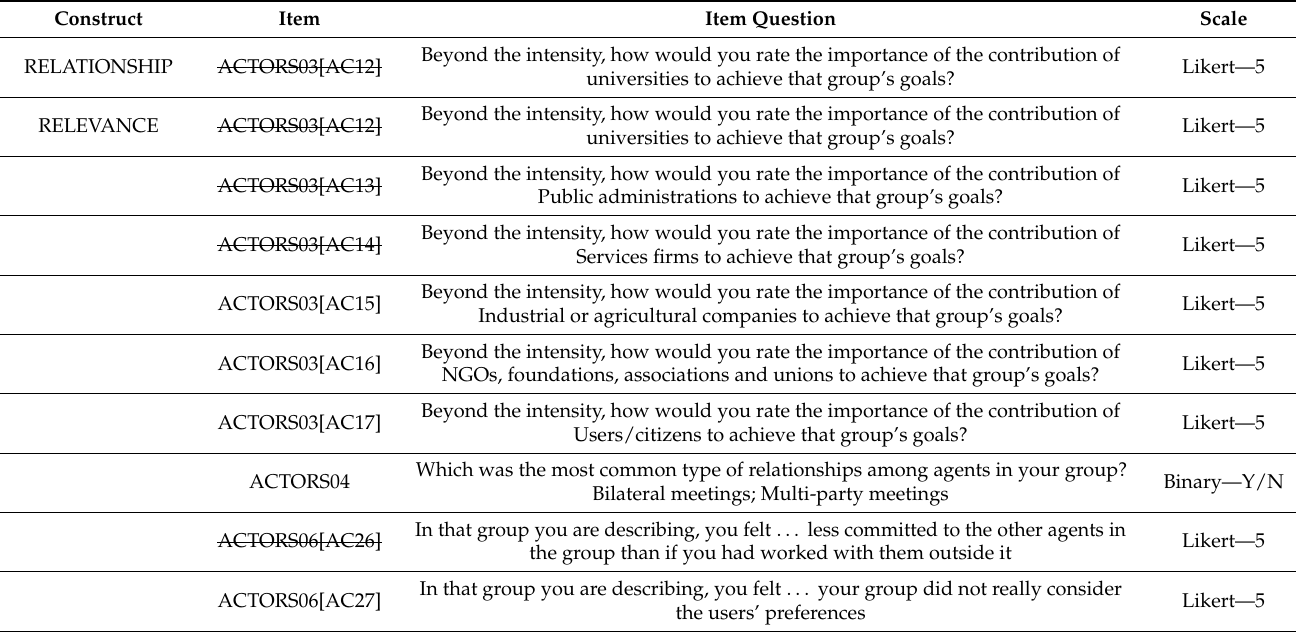
Table A7. List of research constructs and